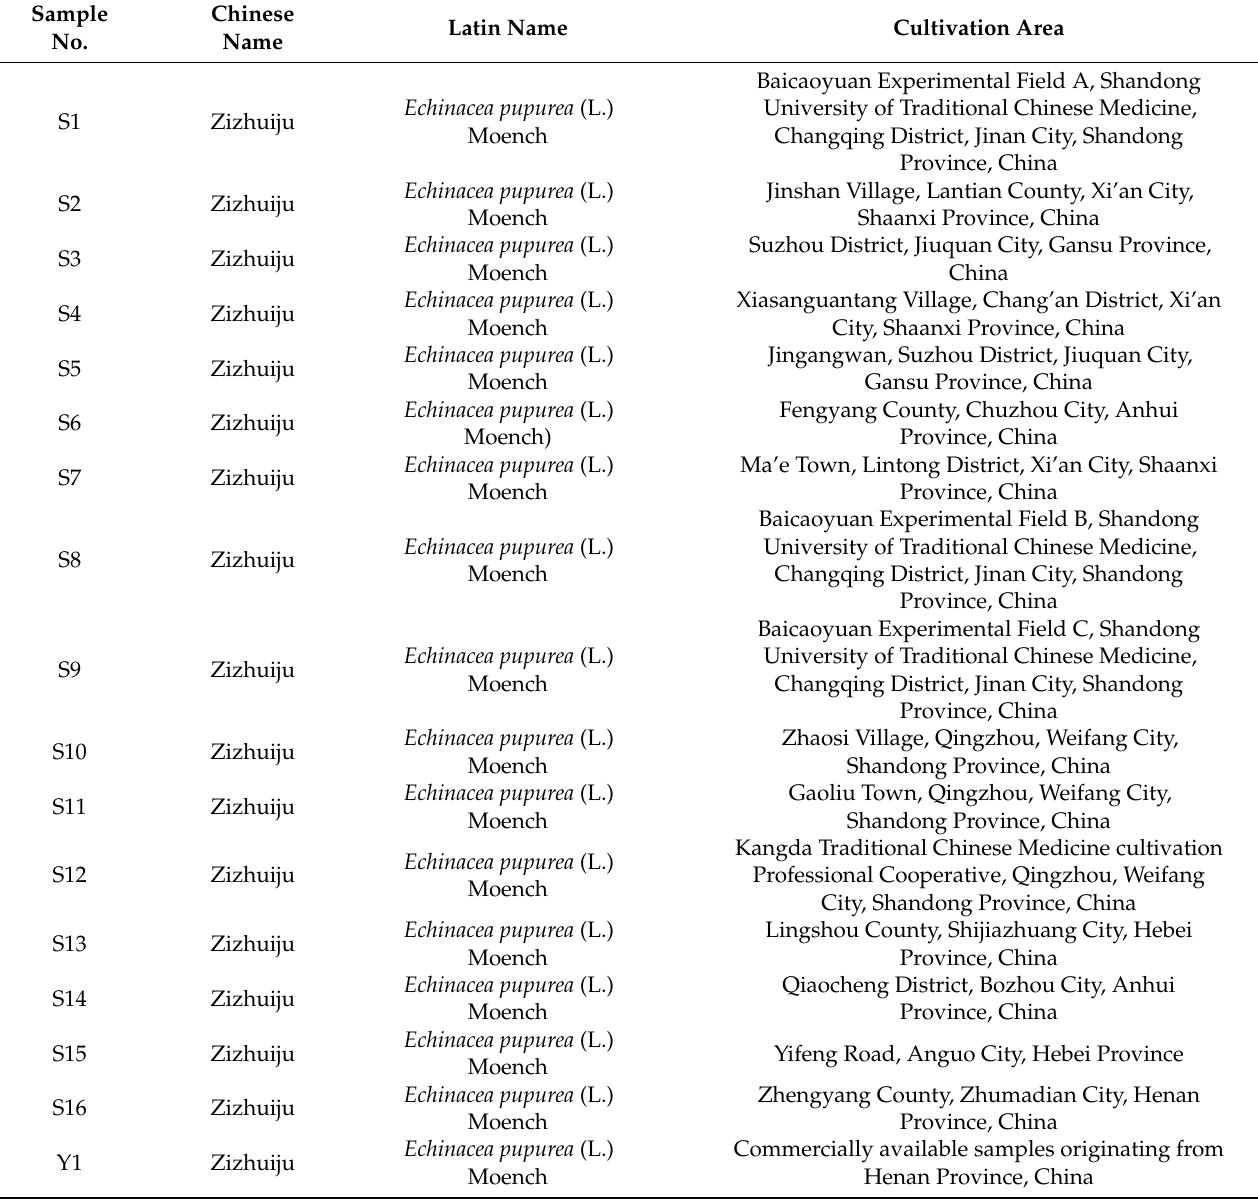
Table 6. Details of Echinacea purpurea (L.) Moench samples from different